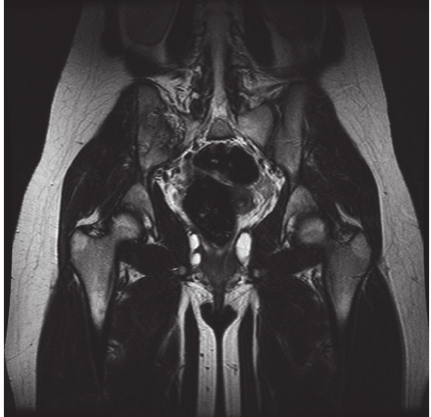
Figure 3: T1-sequence magnetic resonance imaging shows a het- erogeneous, lobulated lytic lesion of the right ilium involving the sacroiliac